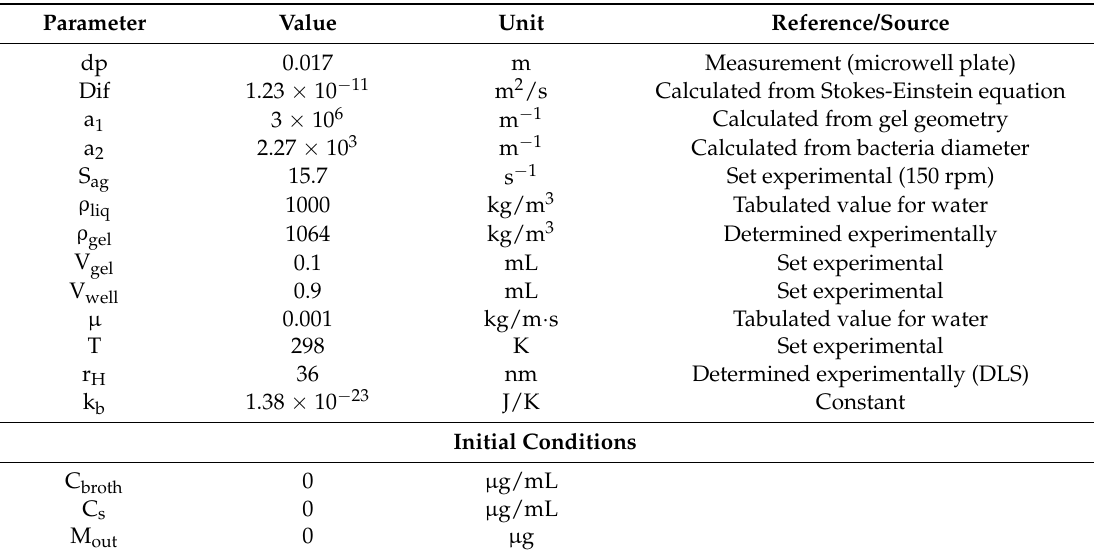
Table 2. Parameters used for